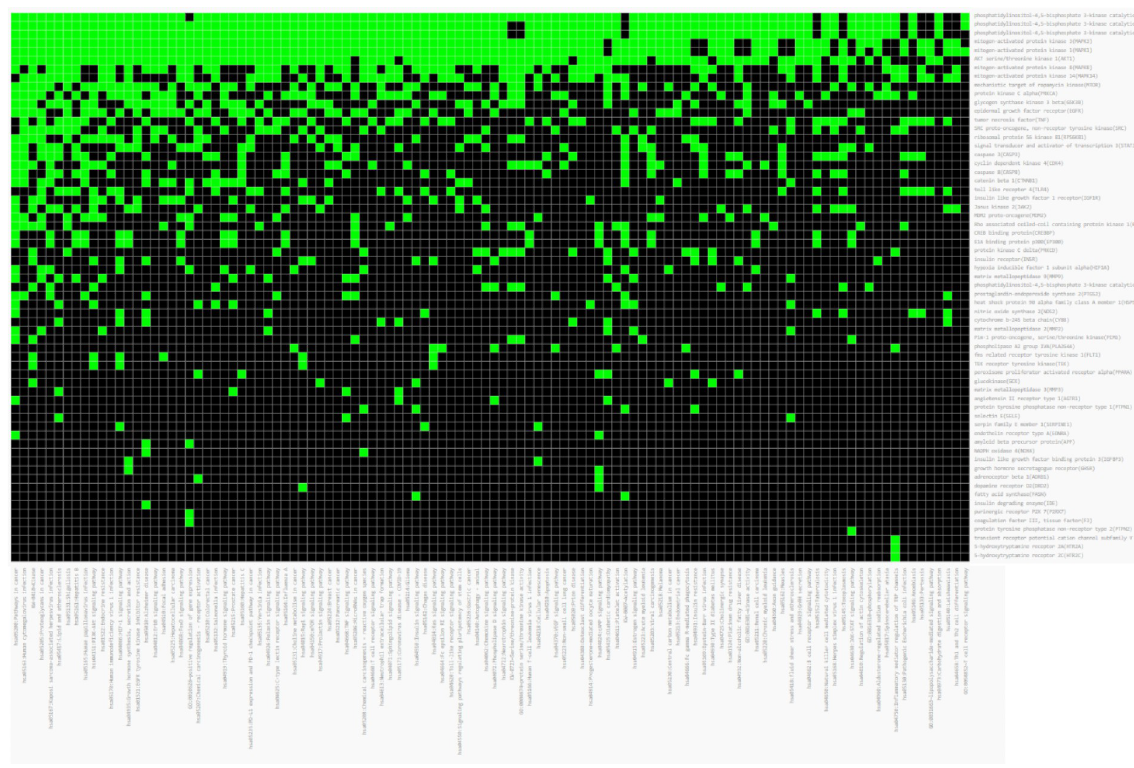
Fig 4. GO and KEGG enrichment